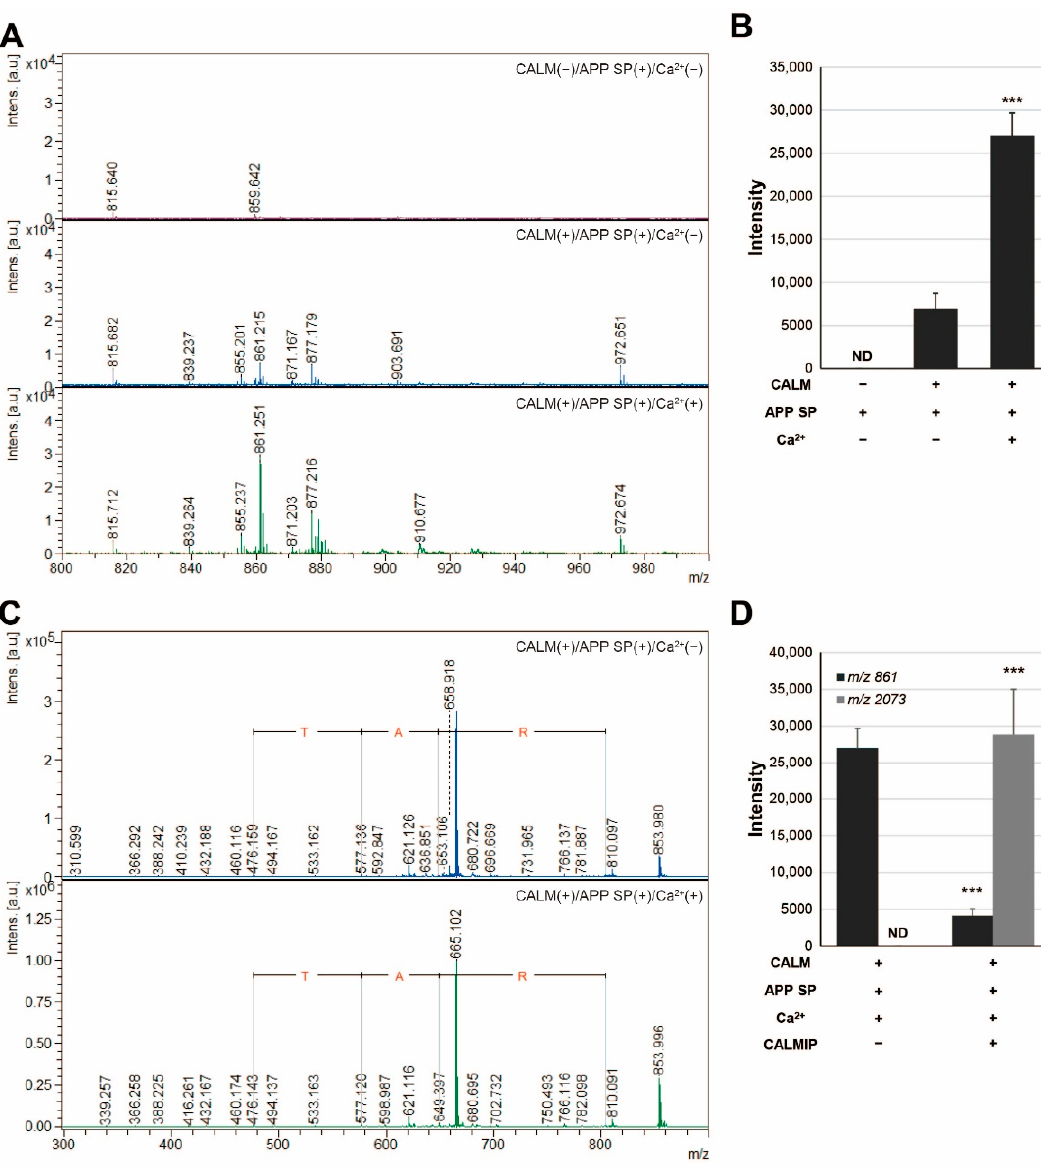
Figure 6. Binding of exosomal SP fragments with CALM in the presence of Ca 2+ . ( A ) The peptide solution extracted from His-tagged CALM was analyzed by MALDI-TOF MS. ( B ) The peak intensity